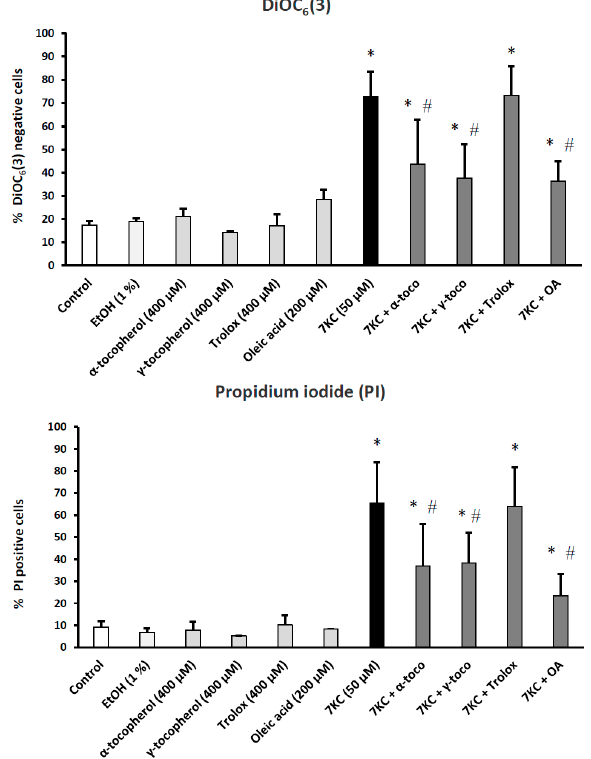
Figure 2. Protective effects of α -tocopherol, and γ -tocopherol, and oleic acid on 7-ketocholesterol-induced loss of mitochondrial transmembrane potential and plasma